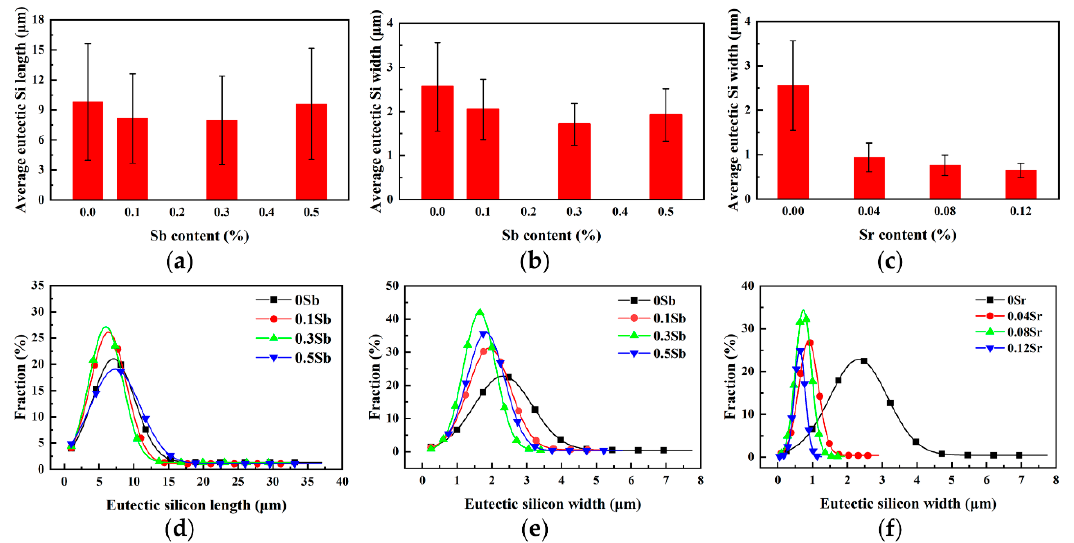
Figure 2. Distribution and variation of eutectic silicon size in Al-8Si alloys with the addition of different modifiers: ( a ) variation of length after Sb modified, ( b ) variation of width after Sb modified, ( c ) variation of width after Sr modified, ( d,e ) distribution of size after Sb modified, ( f ) distribution of size after Sr modified.